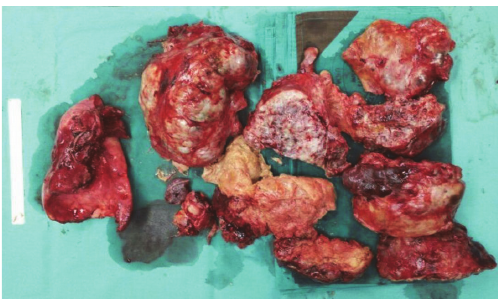
Figure 4: Photograph showing tumour removal via piecemeal